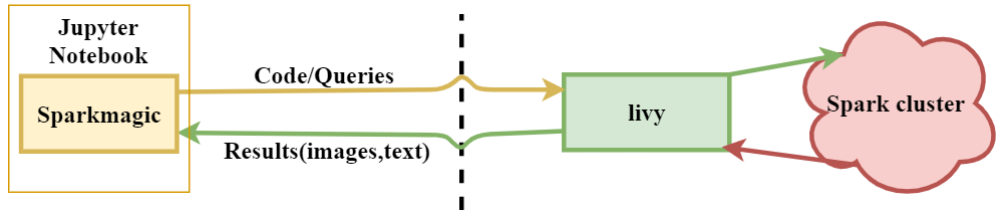
Figure 5. Spark magic provides tools for managing Spark sessions on an external cluster through Livy. Using Spark magic with Jupyter notebook, users can use Spark from their own Jupyter notebook, running on